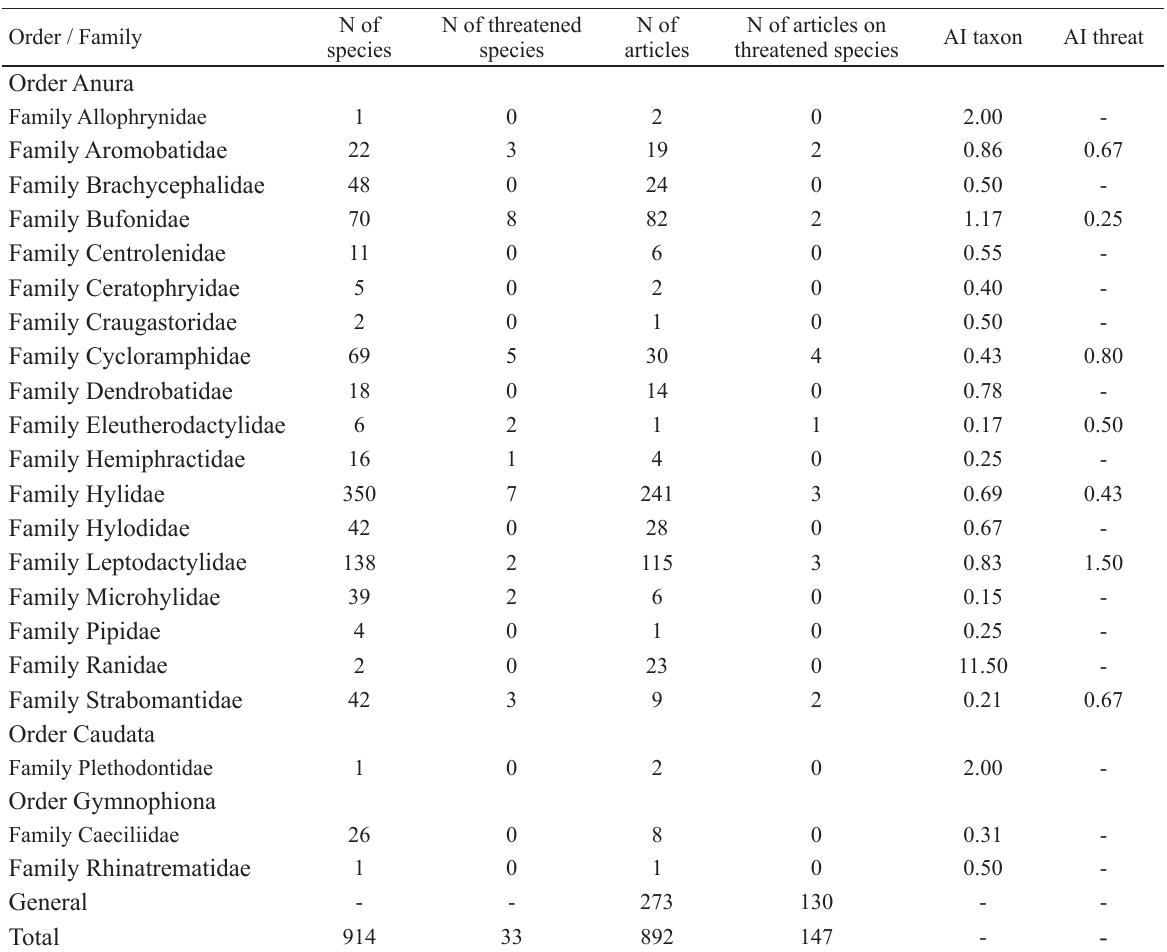
Total number of species, threatened species, published articles, published articles dedicated to threatened species, AI-taxon and AI- threat for each amphibian family recorded in Brazil.